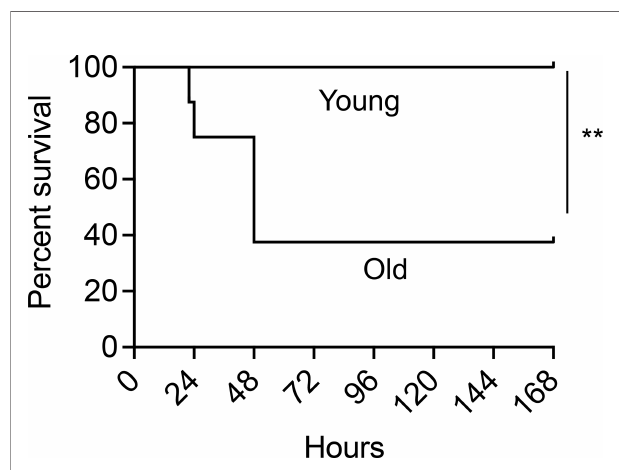
FIGURE 4 | PCV administration fails to protect old mice against S. pneumoniae pulmonary infection. Young and old male C57BL/6 mice were vaccinated with Prevnar-13. Four weeks following vaccination, mice were infected intra-tracheally (i.t.) with 10 6 CFU S. pneumoniae and monitored for survival. Data are pooled from 2 separate experiments with n = 8 mice per group. Signi fi cant differences were determined by Log-Rank (Mantel-Cox) test. ** denotes p < 0.01 .